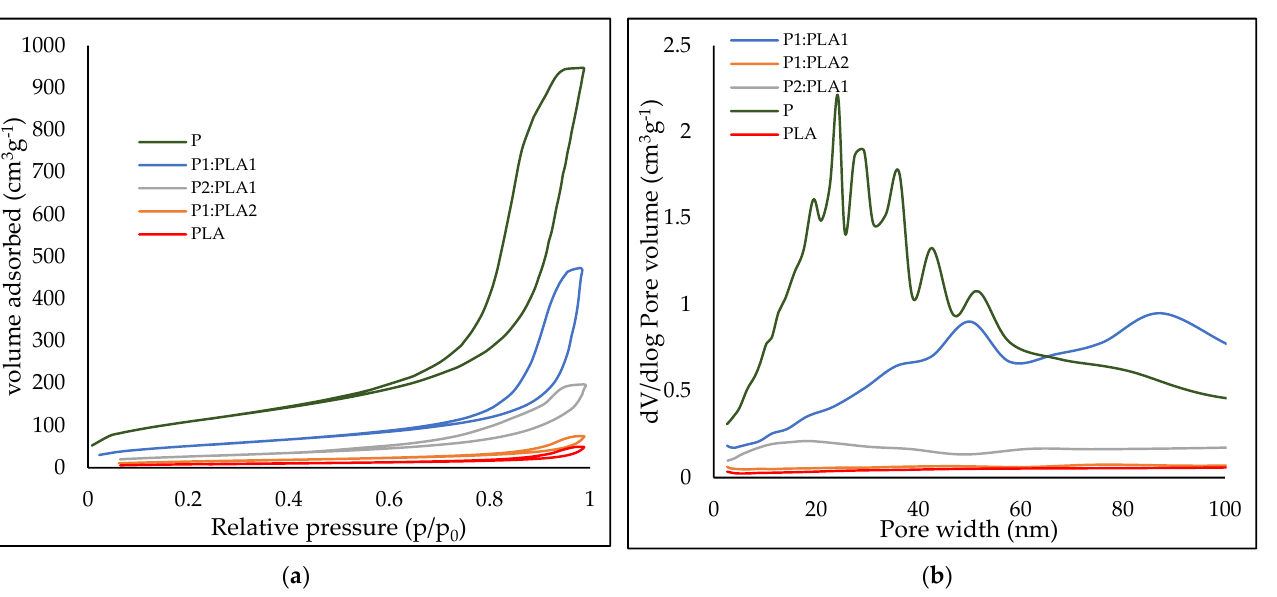
Figure 2. SEM images of ( a ) PLA, ( b ) Pectin, ( c ) P1:PLA2, ( d ) P1:PLA1.